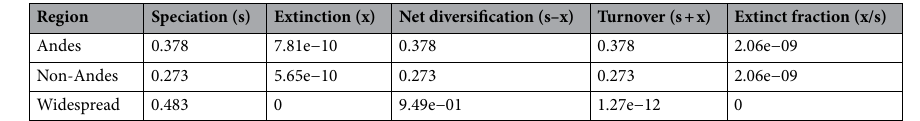
Table 3. Median value of parameters estimated from the average